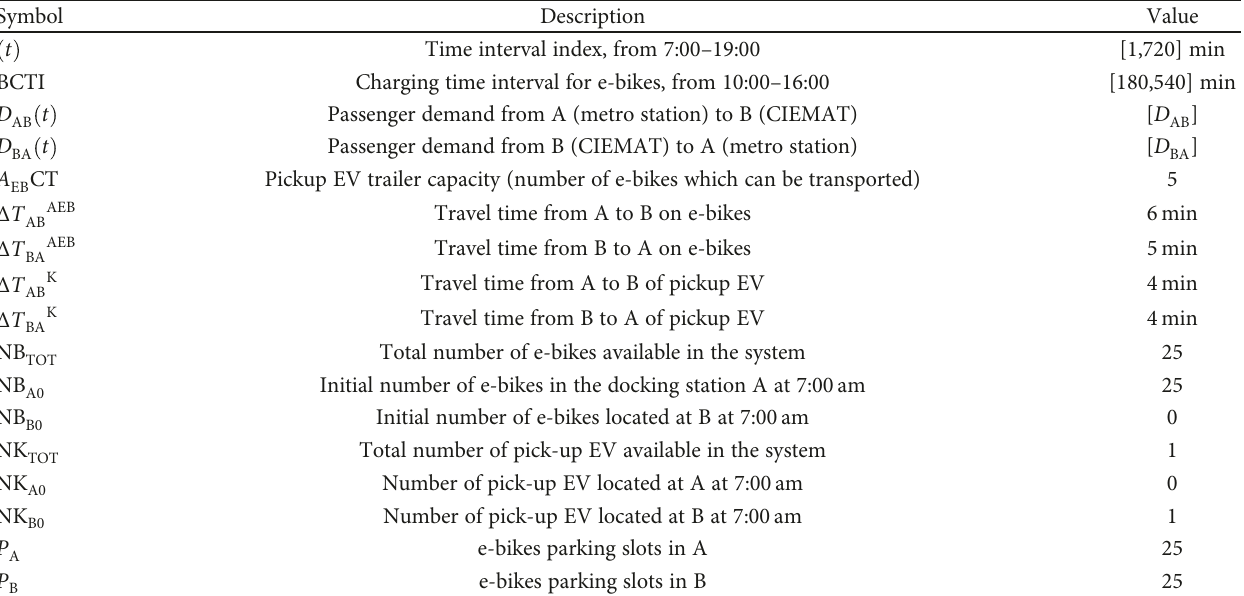
Table 5: Optimization model parameters.